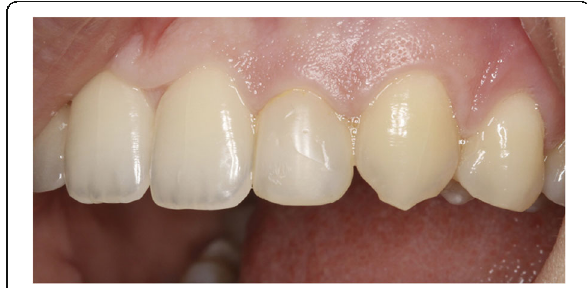
Fig. 4 Vestibular view of contralateral lateral incisor